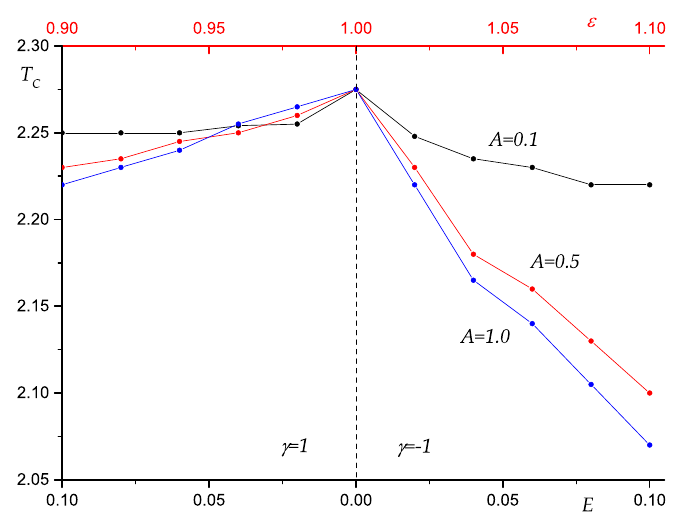
Figure 1. Dependence of the Curie temperature on the strength of the external electric field at different amplitudes of the substrate